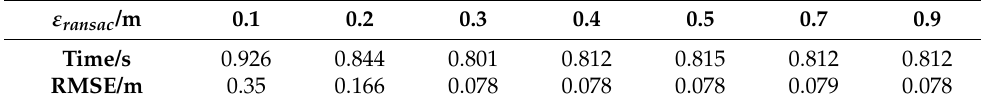
Table 2. ε icp = 0.1 m, the registration results of different ε ransac .